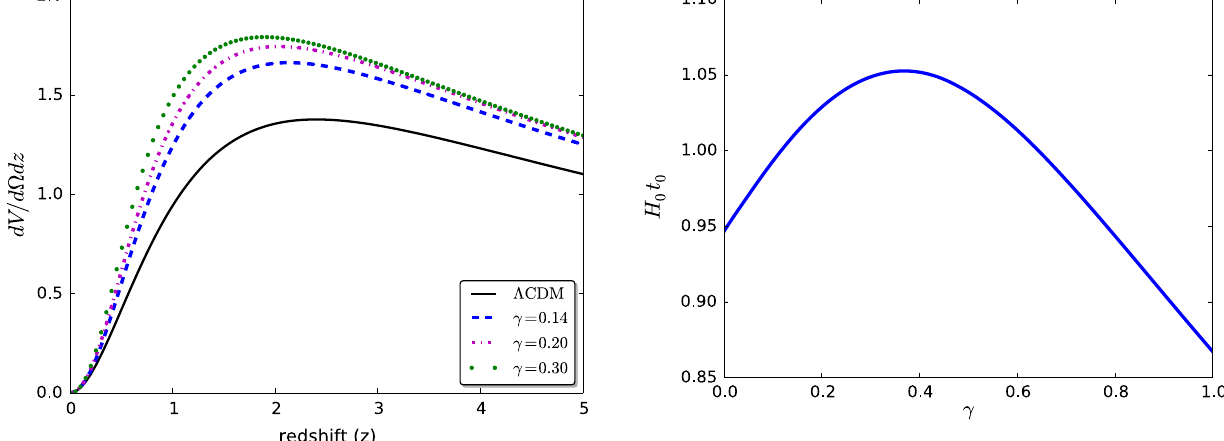
Fig. 8 The quantity H 0 t 0 (age of the Universe times the Hubble con- stant at the present time) as a function of γ . In our dark energy model, the age of the Universe has a maximum at γ × (cid:10) 0 . 36 with maximum value equates to ( H 0 t 0 ) max = 1 . 052. We chose other cosmological parameters in a flat Universe with observational constraint using the JLA